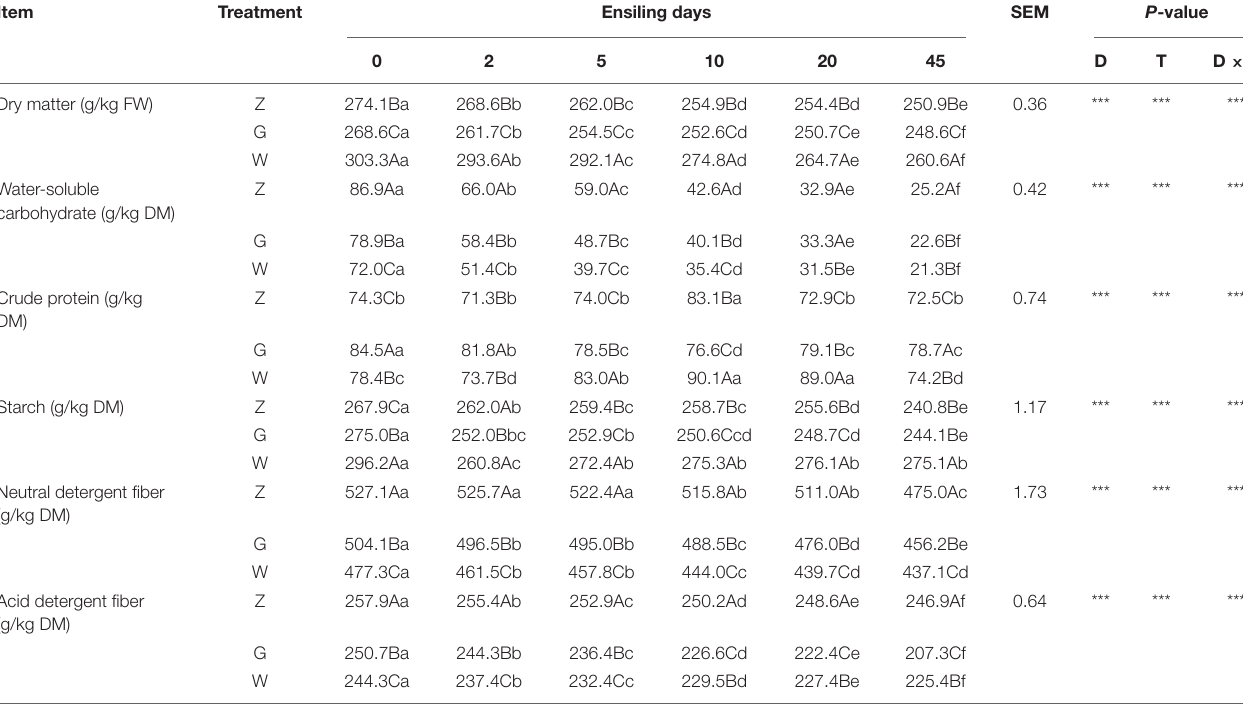
TABLE 1 | Chemical composition of whole-plant maize silage in different regions. Item